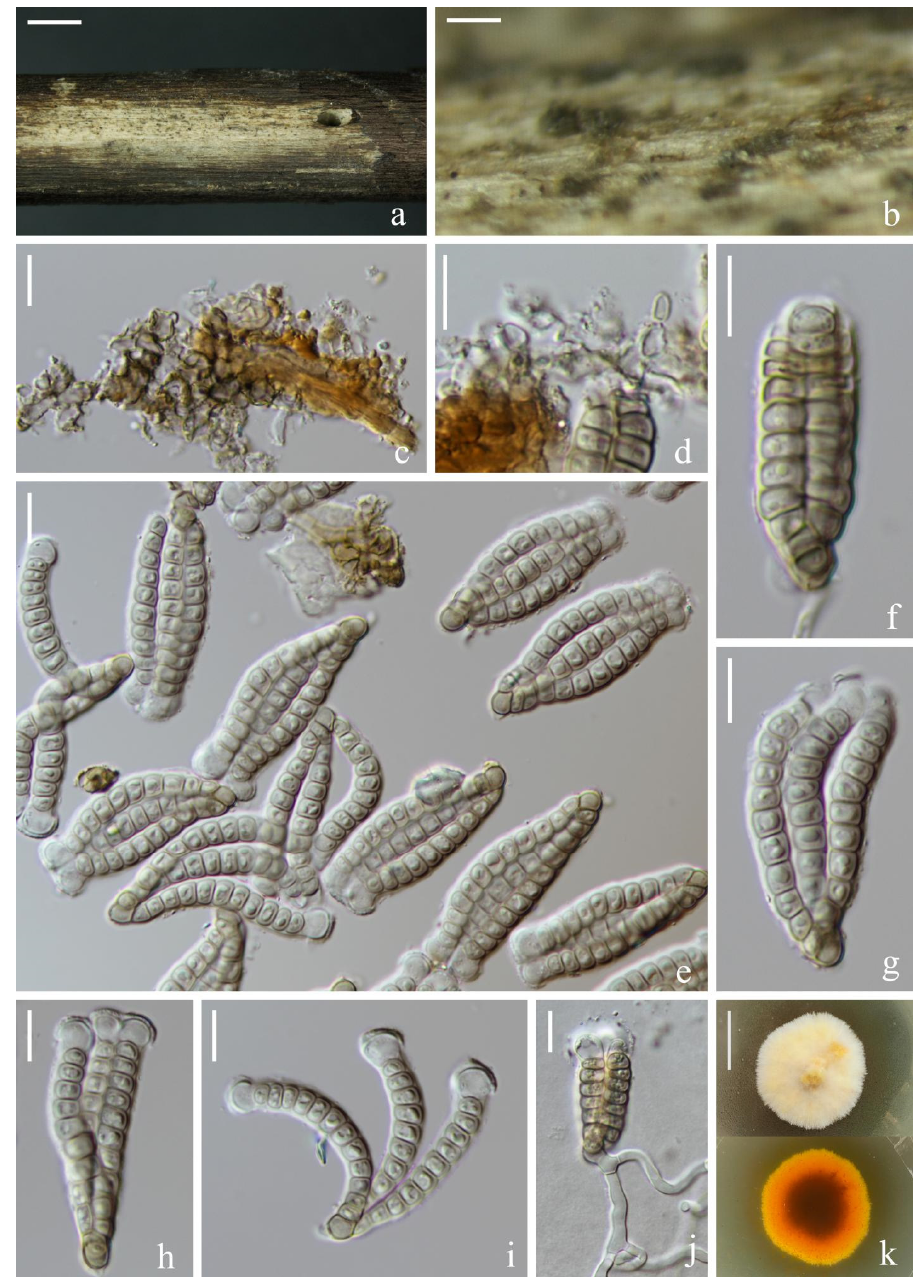
Figure 10. Vikalpa grandispora (KUN-HKAS 122867, holotype). ( a , b ) Colonies on the substratum. ( c ) Conidiomata. ( d ) Conidiogenous cells. ( e , g – i ) Conidia with appendages. ( f ) Conidia. ( j ) Germinating conidium. ( k ) Culture colonies on PDA, reverse (upper) and obverse (lower). Scale bars: ( a ) 1000 µ m, ( b ) 200 µ m, ( c – j ) 10 µ m and ( k ) 1 cm. Culture characteristics: Conidia germinated on PDA within 12 h and germ tubes were produced at the basal cell (Figure 10j). Colonies grew on PDA; mycelium grew slowly, reaching about 2.5 cm in 1 month at room temperature and were loose, flocculent, smooth, white to creamy-yellow on the surface, orange on the edge and gray in the middle on the reverse